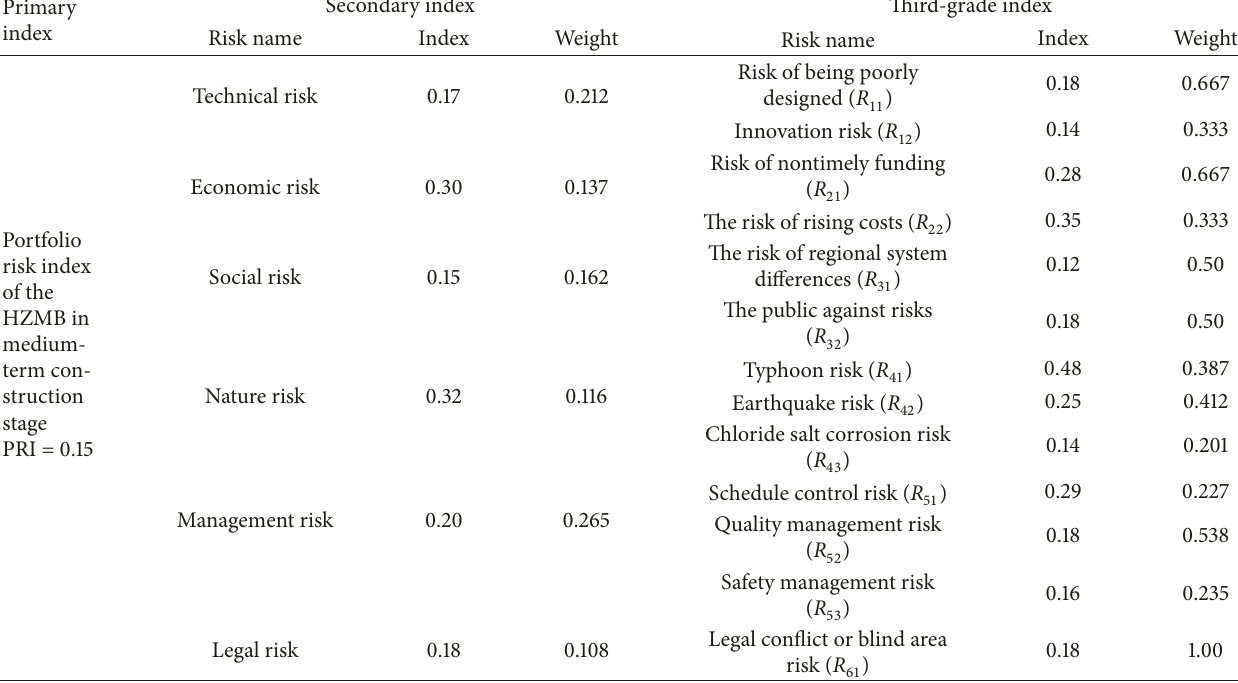
Table 11: Classification and portfolio risk index of the HZMB in medium-term construction stage.